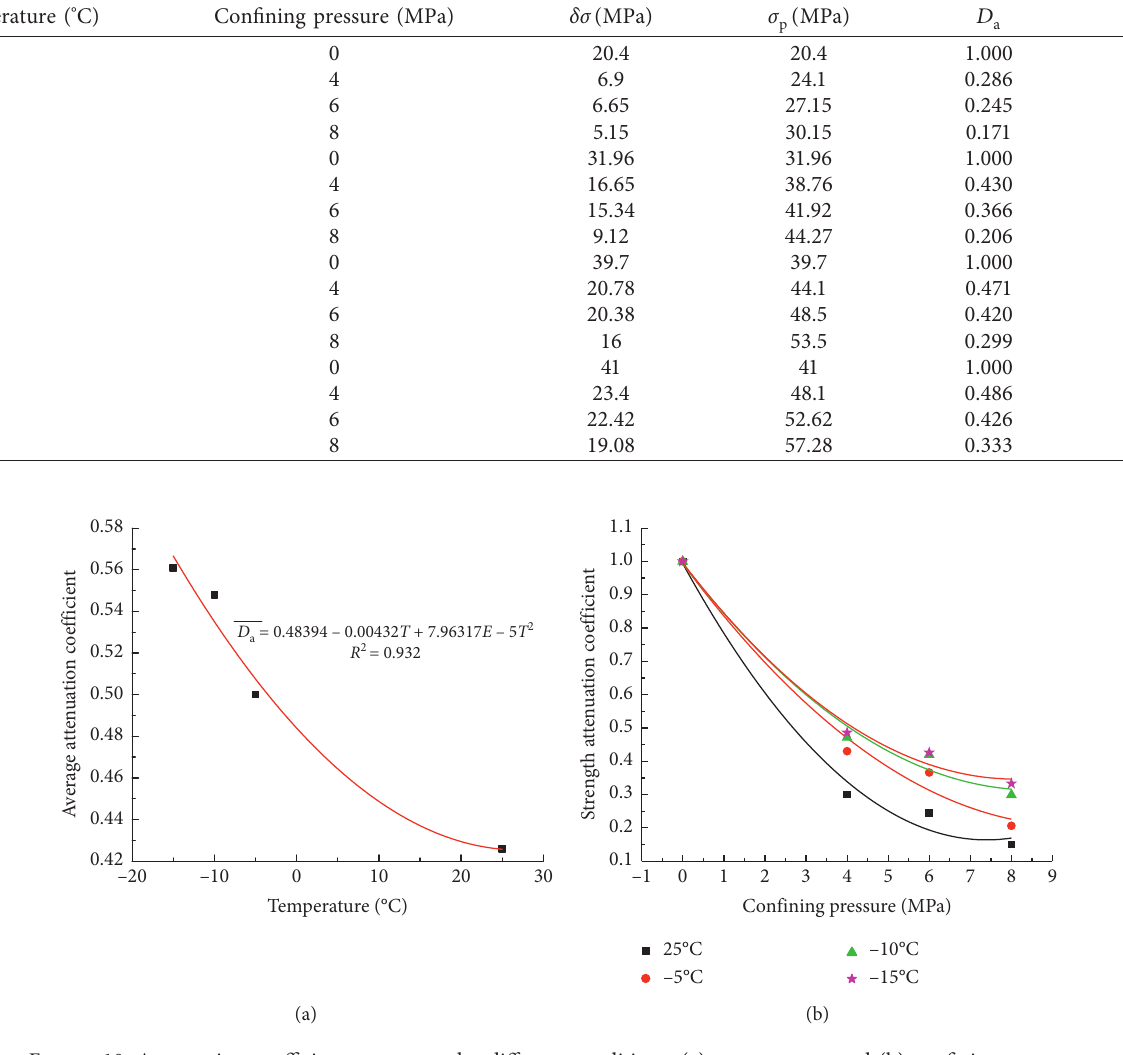
Figure 10: Attenuation coefficients curves under different conditions: (a) temperature, and (b) confining